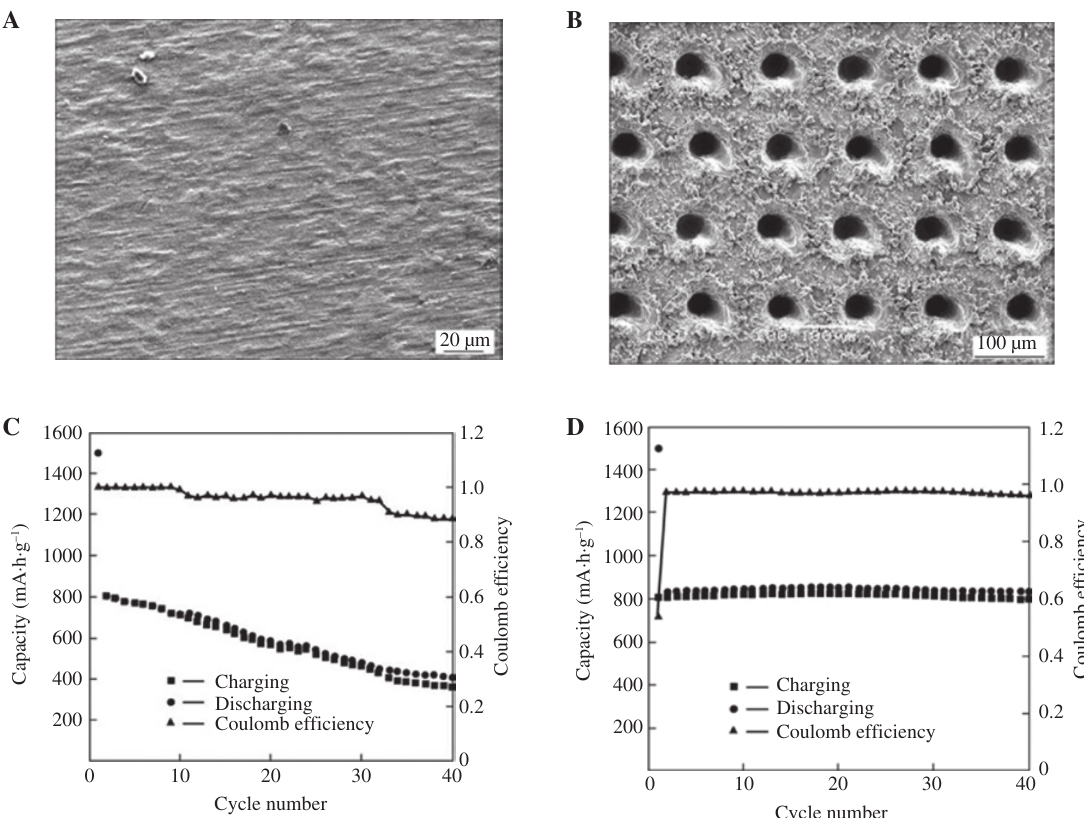
Figure 16: Impact of laser-drilled current collector plate on cell performance: (C, D) specific capacity and coulomb efficiency of silicon-based anodes deposited on (A) unstructured and (B) laser-drilled copper plates (A, B: SEM images, copper plates: 150 μ m in thickness). Reprinted from [15]. means that low battery losses are